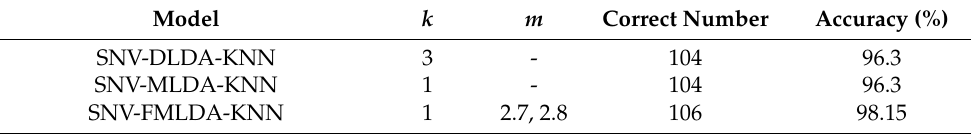
Table 1. Accuracies of tea grade recognition system based on three feature extraction